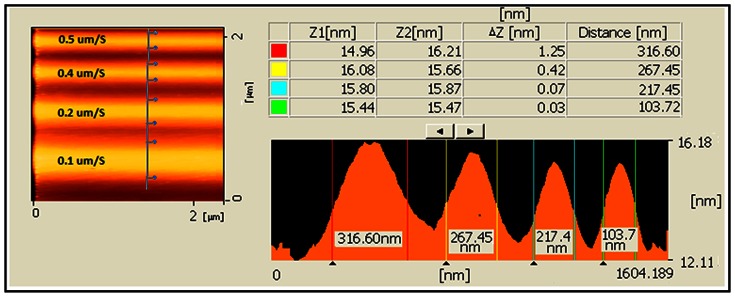
AFM profile image for width comparison of the oxide track for different writing speeds during LAO (Au coated tip at 8V applied voltage).